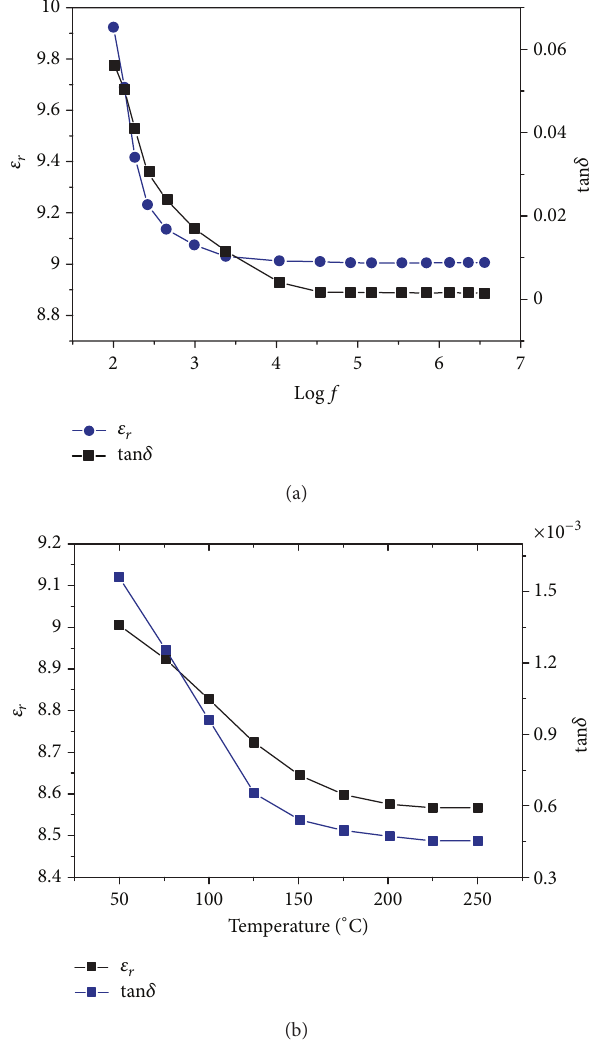
Figure 12: (a) Variation of dielectric constant 𝜀 𝑟 and loss factor tan 𝛿 with respect to frequencies and (b) with respect to